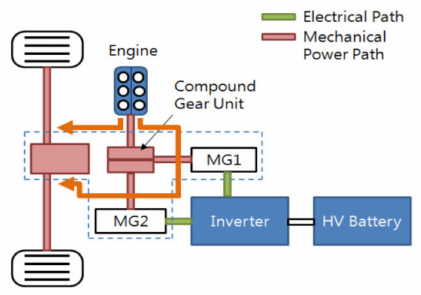
Figure 2. Schematic of hybrid electric power system.